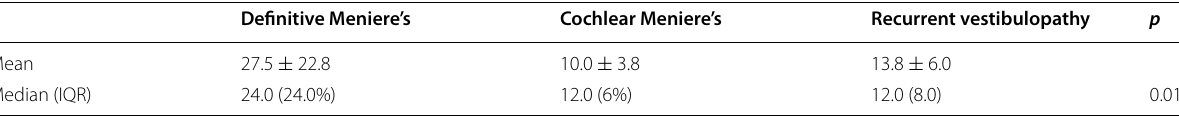
Table 3 Duration of the disease